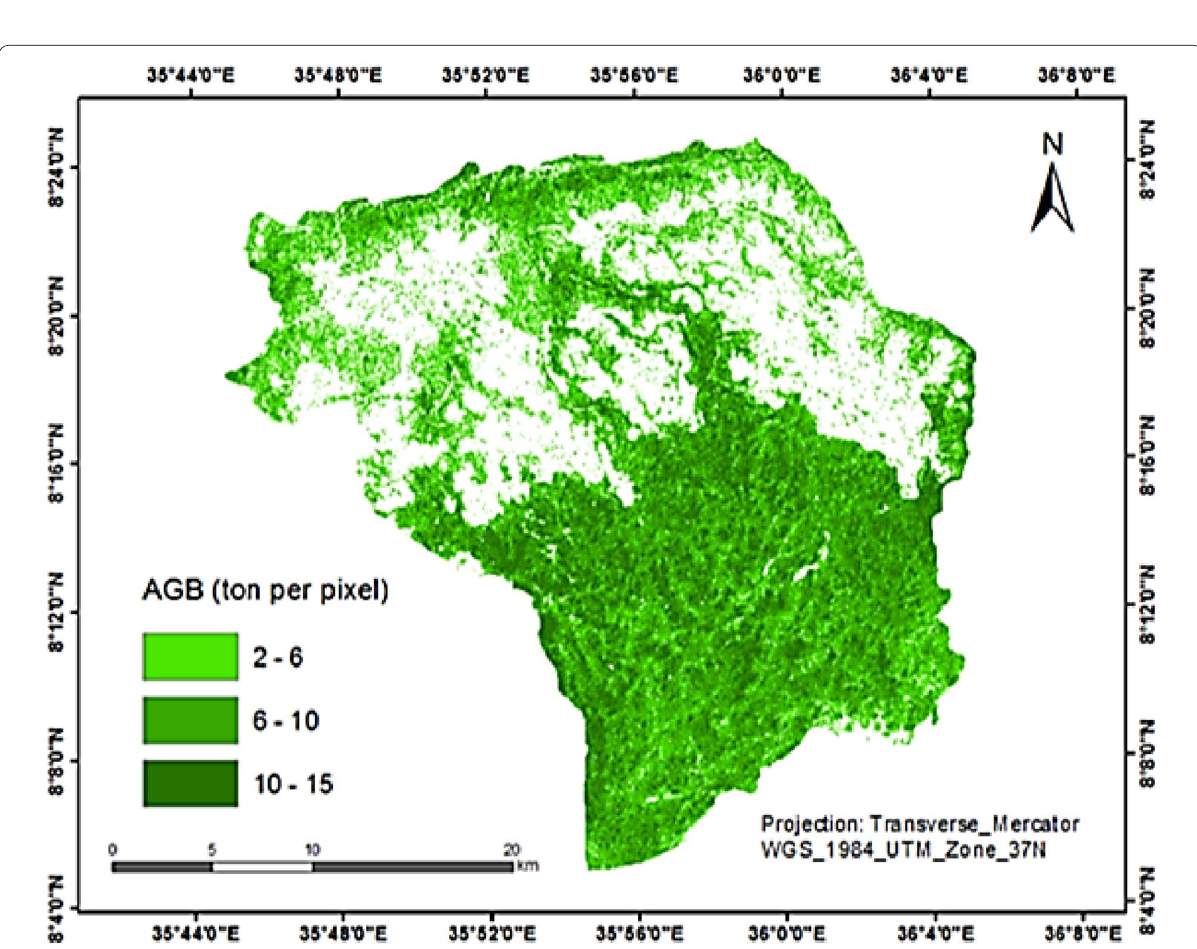
Fig. 11 Map of the predicted values of the above-ground biomass of Yayu forest biosphere